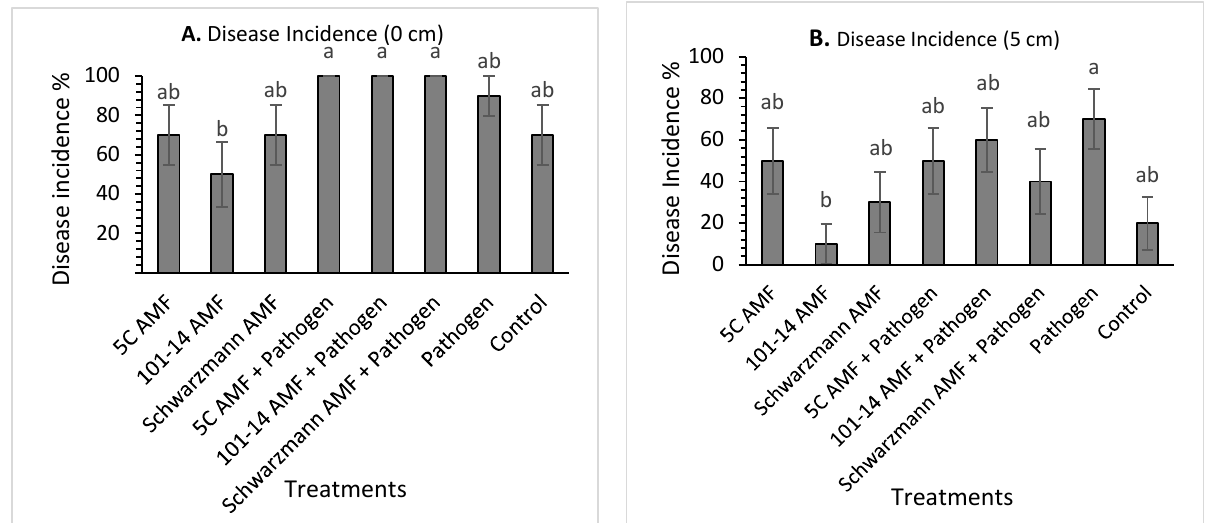
Figure 5. C at 0 cm ( A ) and 5 cm ( B ) from stem base colonized with different AMF communities originating from different rootstocks (101-14, 5C and Schwarzmann) and inoculated with black foot pathogen isolates. Bars with different letters are significantly different ( p ≤ 0.05) based on the SED generated from GLM analysis. Error bars show ± SED.